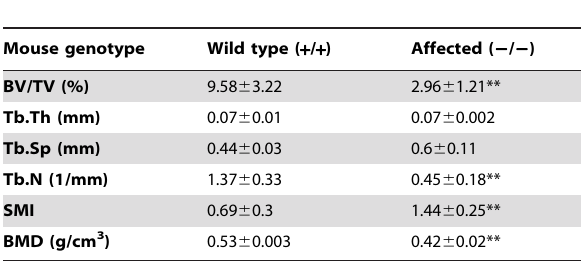
Table 1. Structural parameters for trabecular